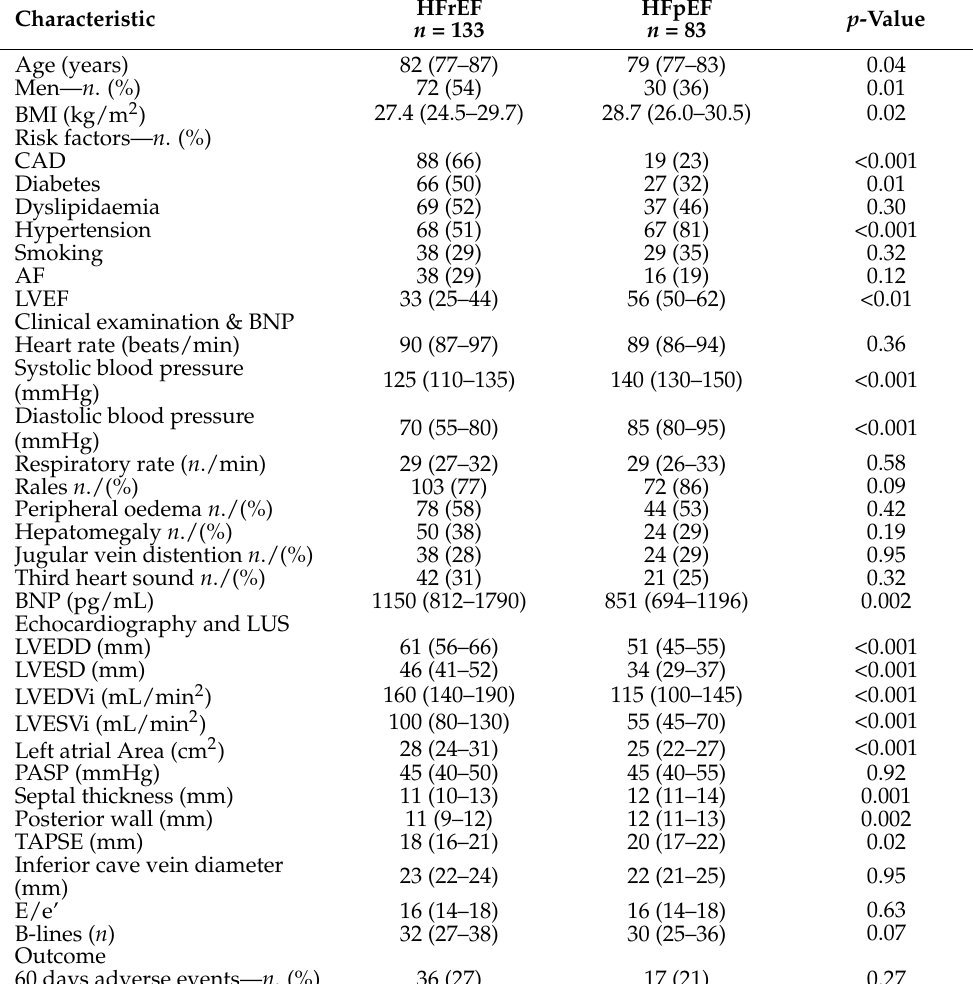
Table 1. Clinical risk factors and echocardiographic features of enrolled patients divided by ejection fraction